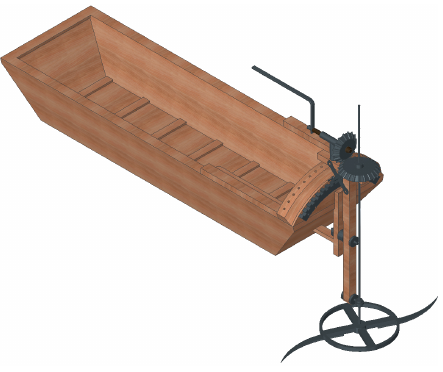
Figure 1. Isometric view of the 3D model.